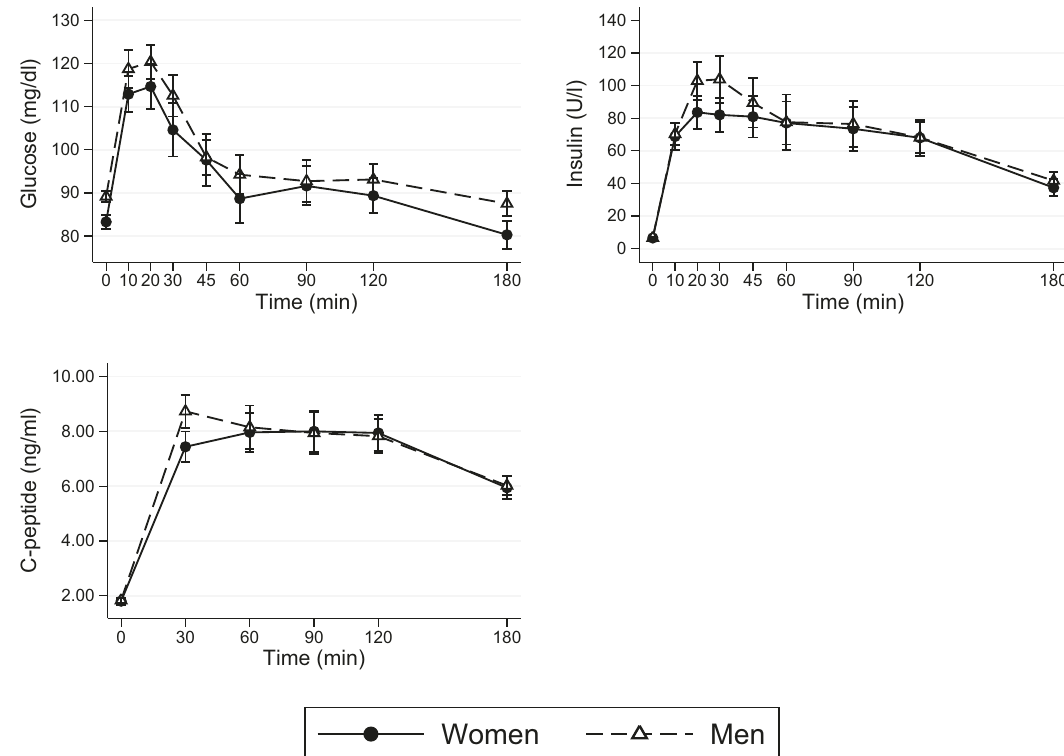
Fig. 1 Glucose, insulin, and C-peptide responses to a balanced mixed meal. Values are serum glucose, insulin and C-peptide concentrations, expressed as mean ± standard error, observed in men and women after consumption of a balanced mixed